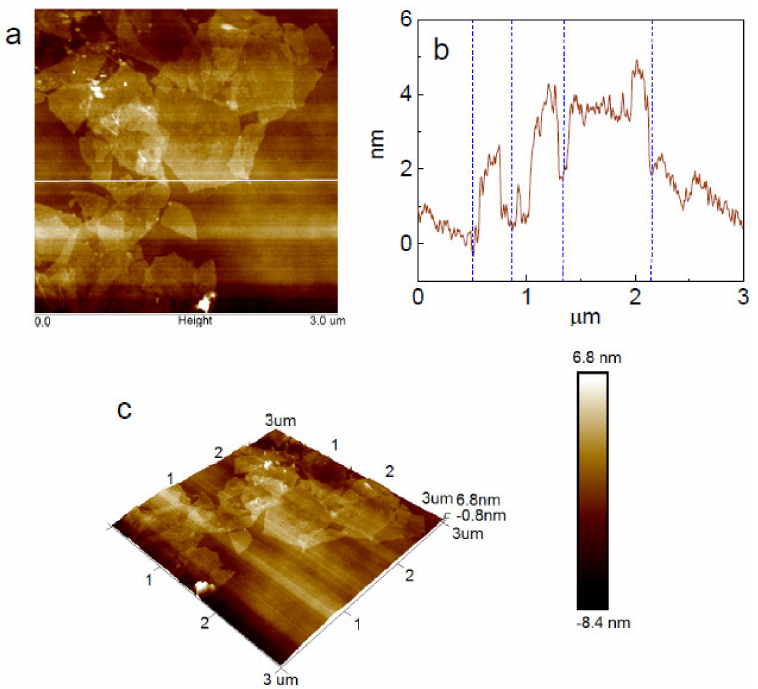
Figure 2. AFM images of the prepared graphene oxide nanosheets; ( a ) 2D height image; ( b ) section analysis; ( c ) 3D height